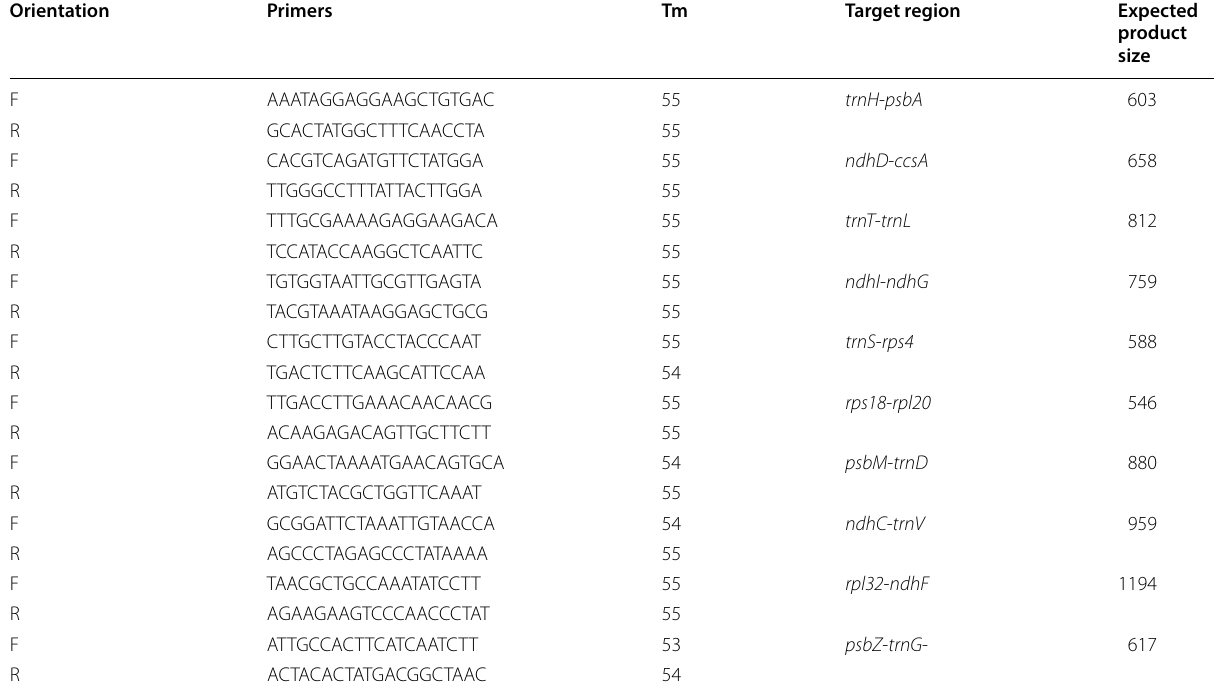
Table 5 Details of ten primers that target the most divergent regions in the chloroplast genomes of Senecioneae